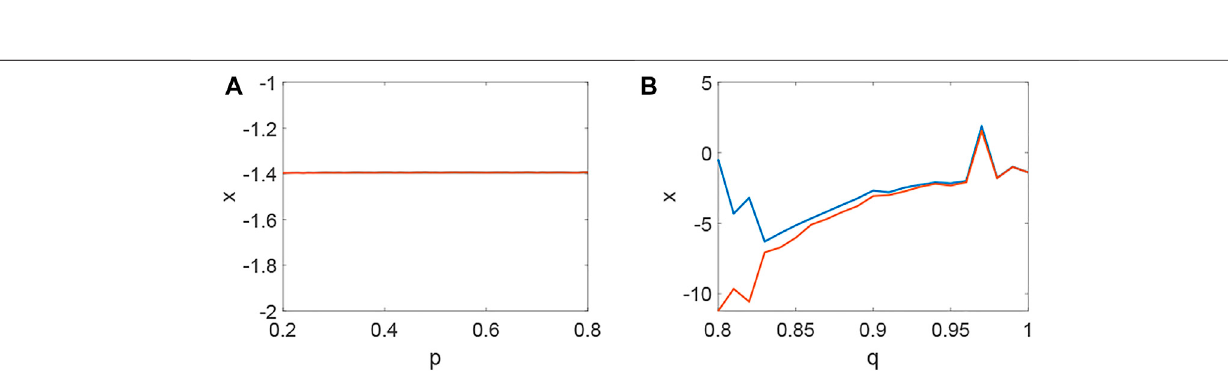
FIGURE 9 | The pattern formation of system (1) when τ = 68. (A) The pattern formation when p = 0, q = 0. (B) The pattern formation when p = 0.01, q = 0. (C) The pattern formation when p = 0.1, q = 0. (D) The pattern formation when p = 0.1, q = 0.96.